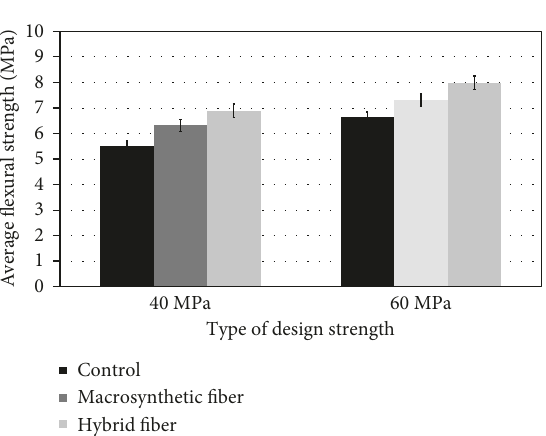
Figure 16: Compressive strength of optimum mix ratio. Figure 17: Flexural strength of optimum mix